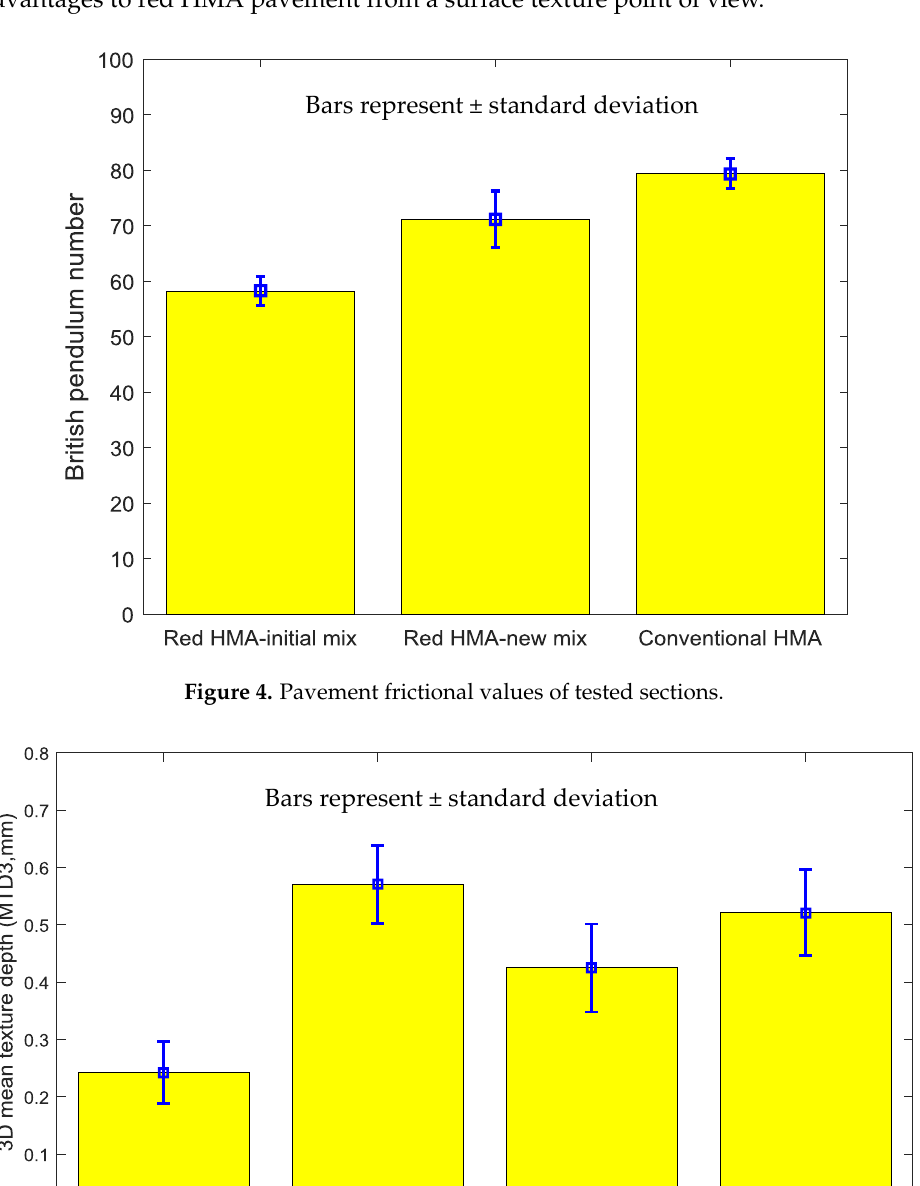
Figure 5. Pavement 3D mean macrotexture depth of tested sections.